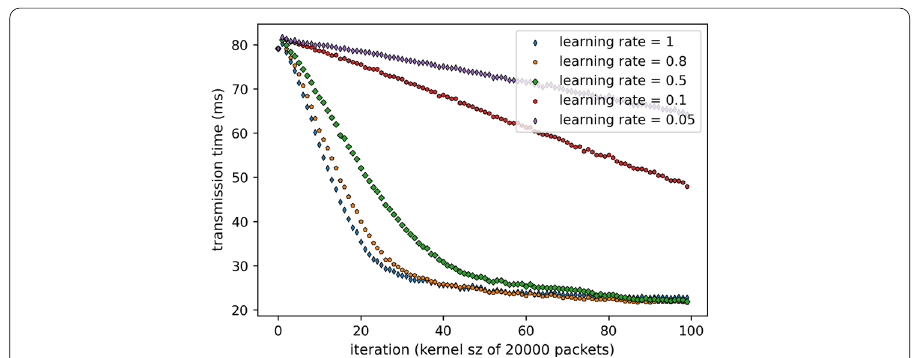
Fig. 12 Modified algorithm with different learning rates